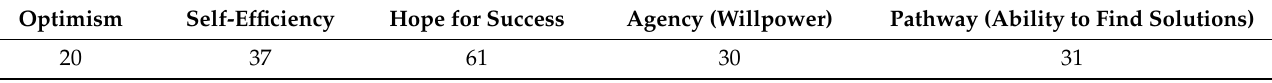
Table 12. Personality variables of the ultramarathon runner.